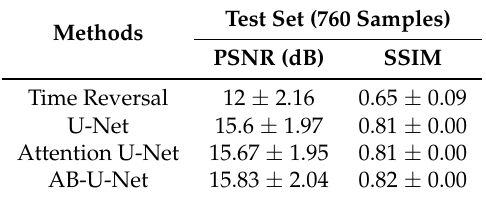
Table 1. PSNR and SSIM under reconstructed images on Test